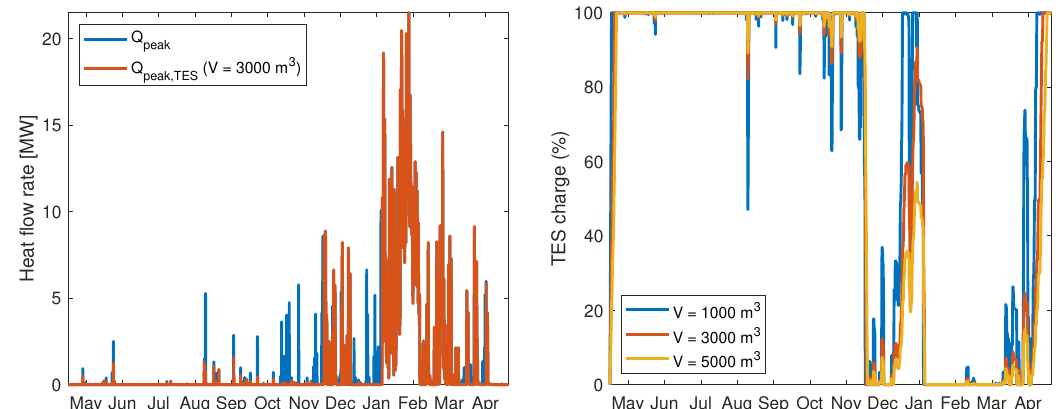
Figure 4. Hourly peak heating based on data ( Q peak ) and the required peak heating when using a TES tank with a volume of 3000 m 3 ( Q peak , TES ) ( left ). The relative TES charge for three different tank sizes: V = 1000, 3000 and 5000 m 3 ( right ).